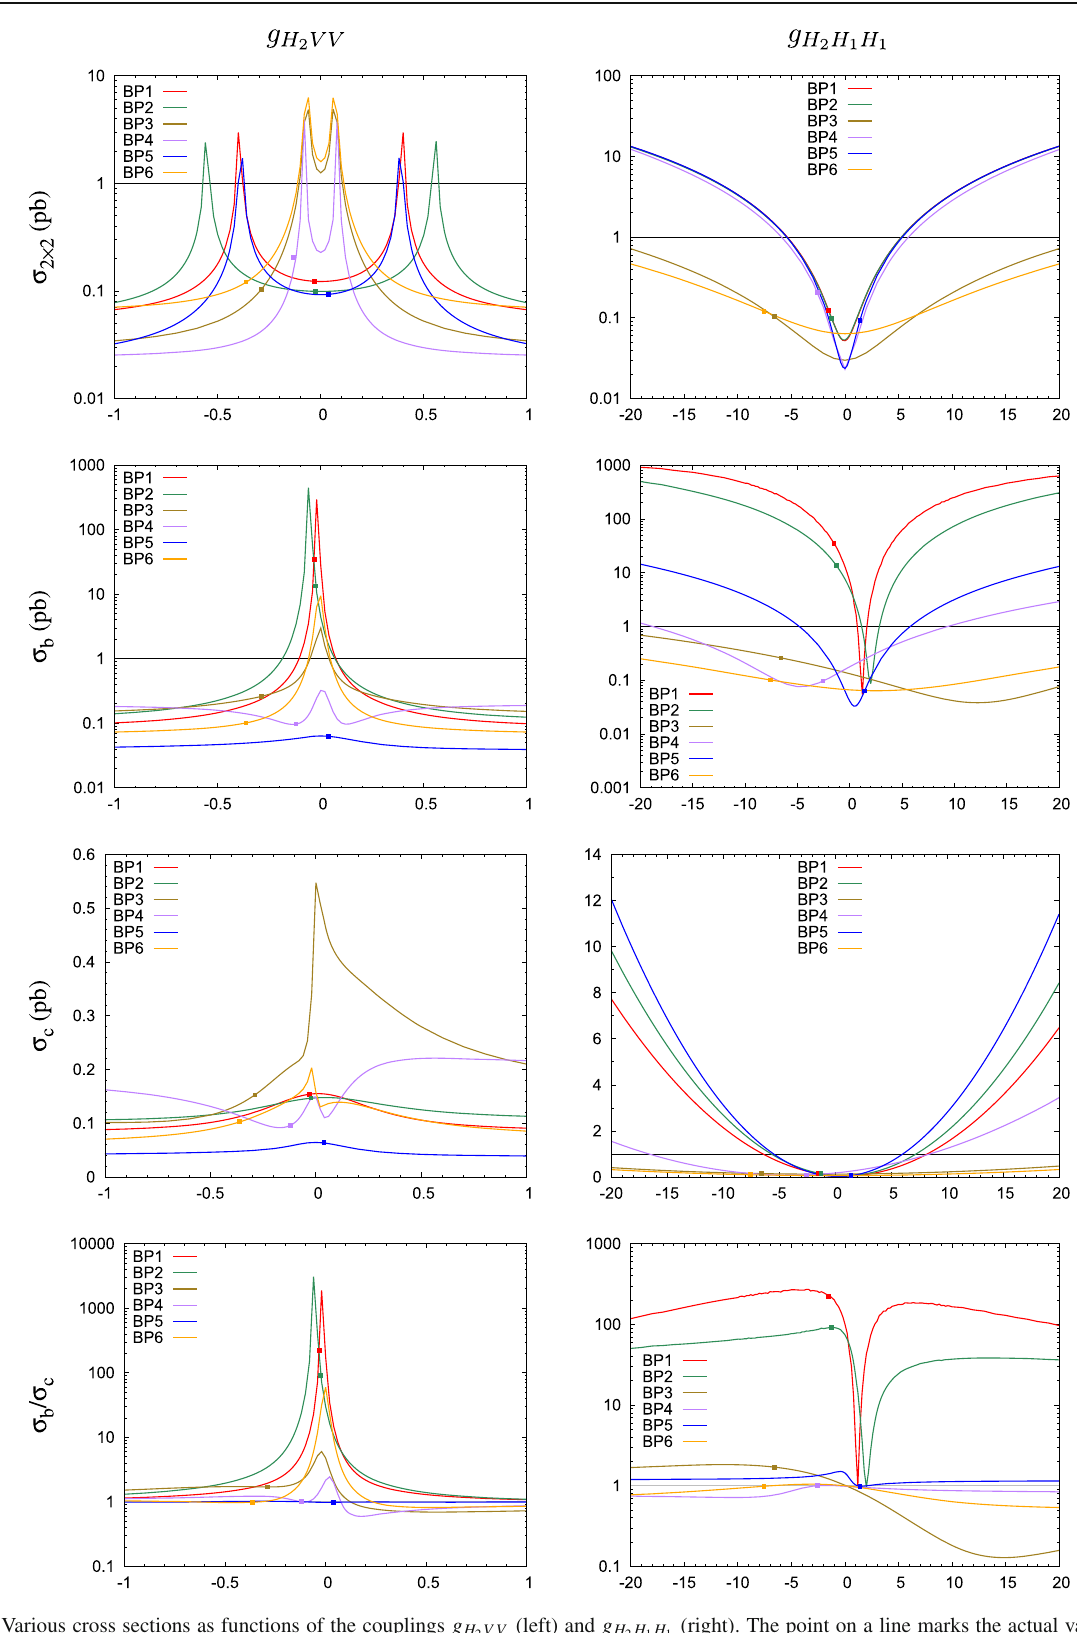
(left) and g H (right). The point on a line marks the actual value of the 2 VV 2 H 1 H 1